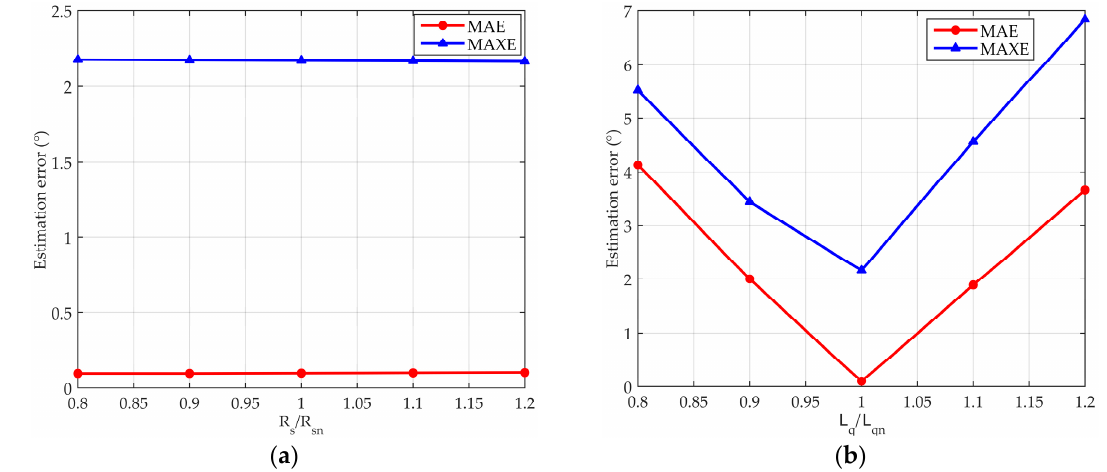
Figure 20. Mean absolute error (MAE) and Maximum absolute error (MAXE) of the SMO based load angle estimator due to the variation of the estimator’s parameter: ( a ) Stator resistance R s ; ( b ) Quadrature axis inductance L q .